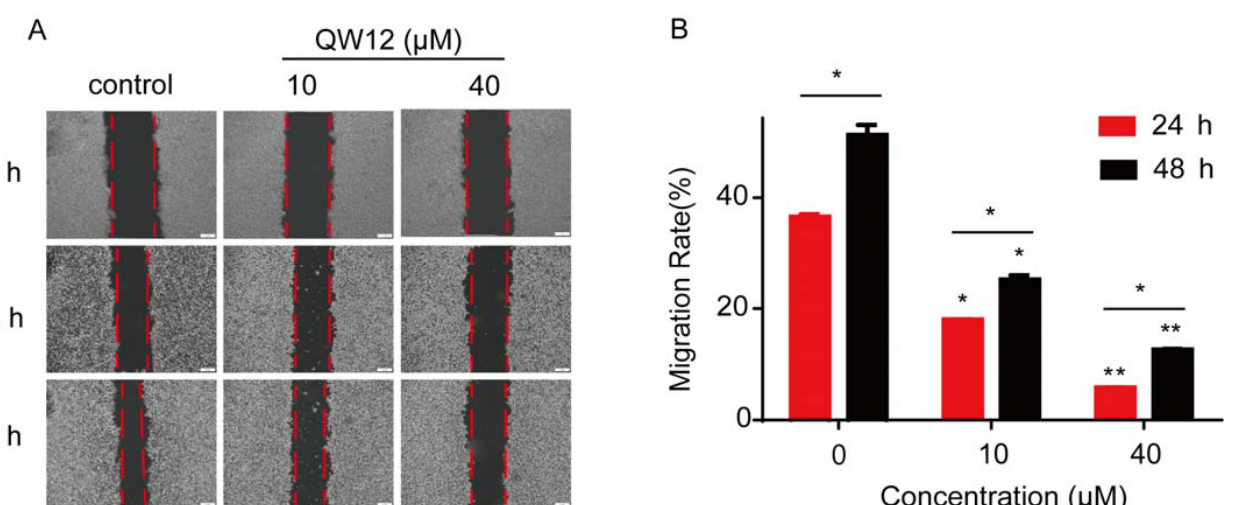
Figure 4. QW12 inhibited the proliferation of HeLa cells. ( A ) The plate ‐ cloning experiment was used to detect changes in cell proliferation after the treatment of cells with QW12 . ( B ) Quantitative anal ‐ ysis of proliferation changes. Values are presented in means ± SD of three independent experiments. * p < 0.05, *** p < 0.001. 3.2.3. QW12 Induces Intracellular ROS Production Reactive oxygen species (ROS) are generated as by ‐ products of normal aerobic me ‐ tabolism or as second messengers in various signal transduction pathways in response to oxidative stress, which can elicit a wide spectrum of biological responses, such as macro ‐ molecular damage and cell death [25–27]. Substantial evidence suggests that the genera ‐ tion of ROS is part of the mechanism by which many anticancer agents kill tumor cells [28–30]. It is reported that nifuroxazide could induce apoptosis through ROS accumula ‐ tion [15]. Although the 5 ‐ nitro group is believed to be the main responsible mechanism for the generation of ROS for nifuroxazide, there is evidence that ROS generation can also be independent of the presence of the nitro group [31]. Since the side chain of QW12 is similar to nifuroxazide, we were motivated to figure out whether QW12 could also trigger ROS production in HeLa cells. As illustrated in Figure 5A,B, compound QW12 stimulates ROS accumulation in a dose ‐ dependent manner in HeLa cells. To further confirm the cor ‐